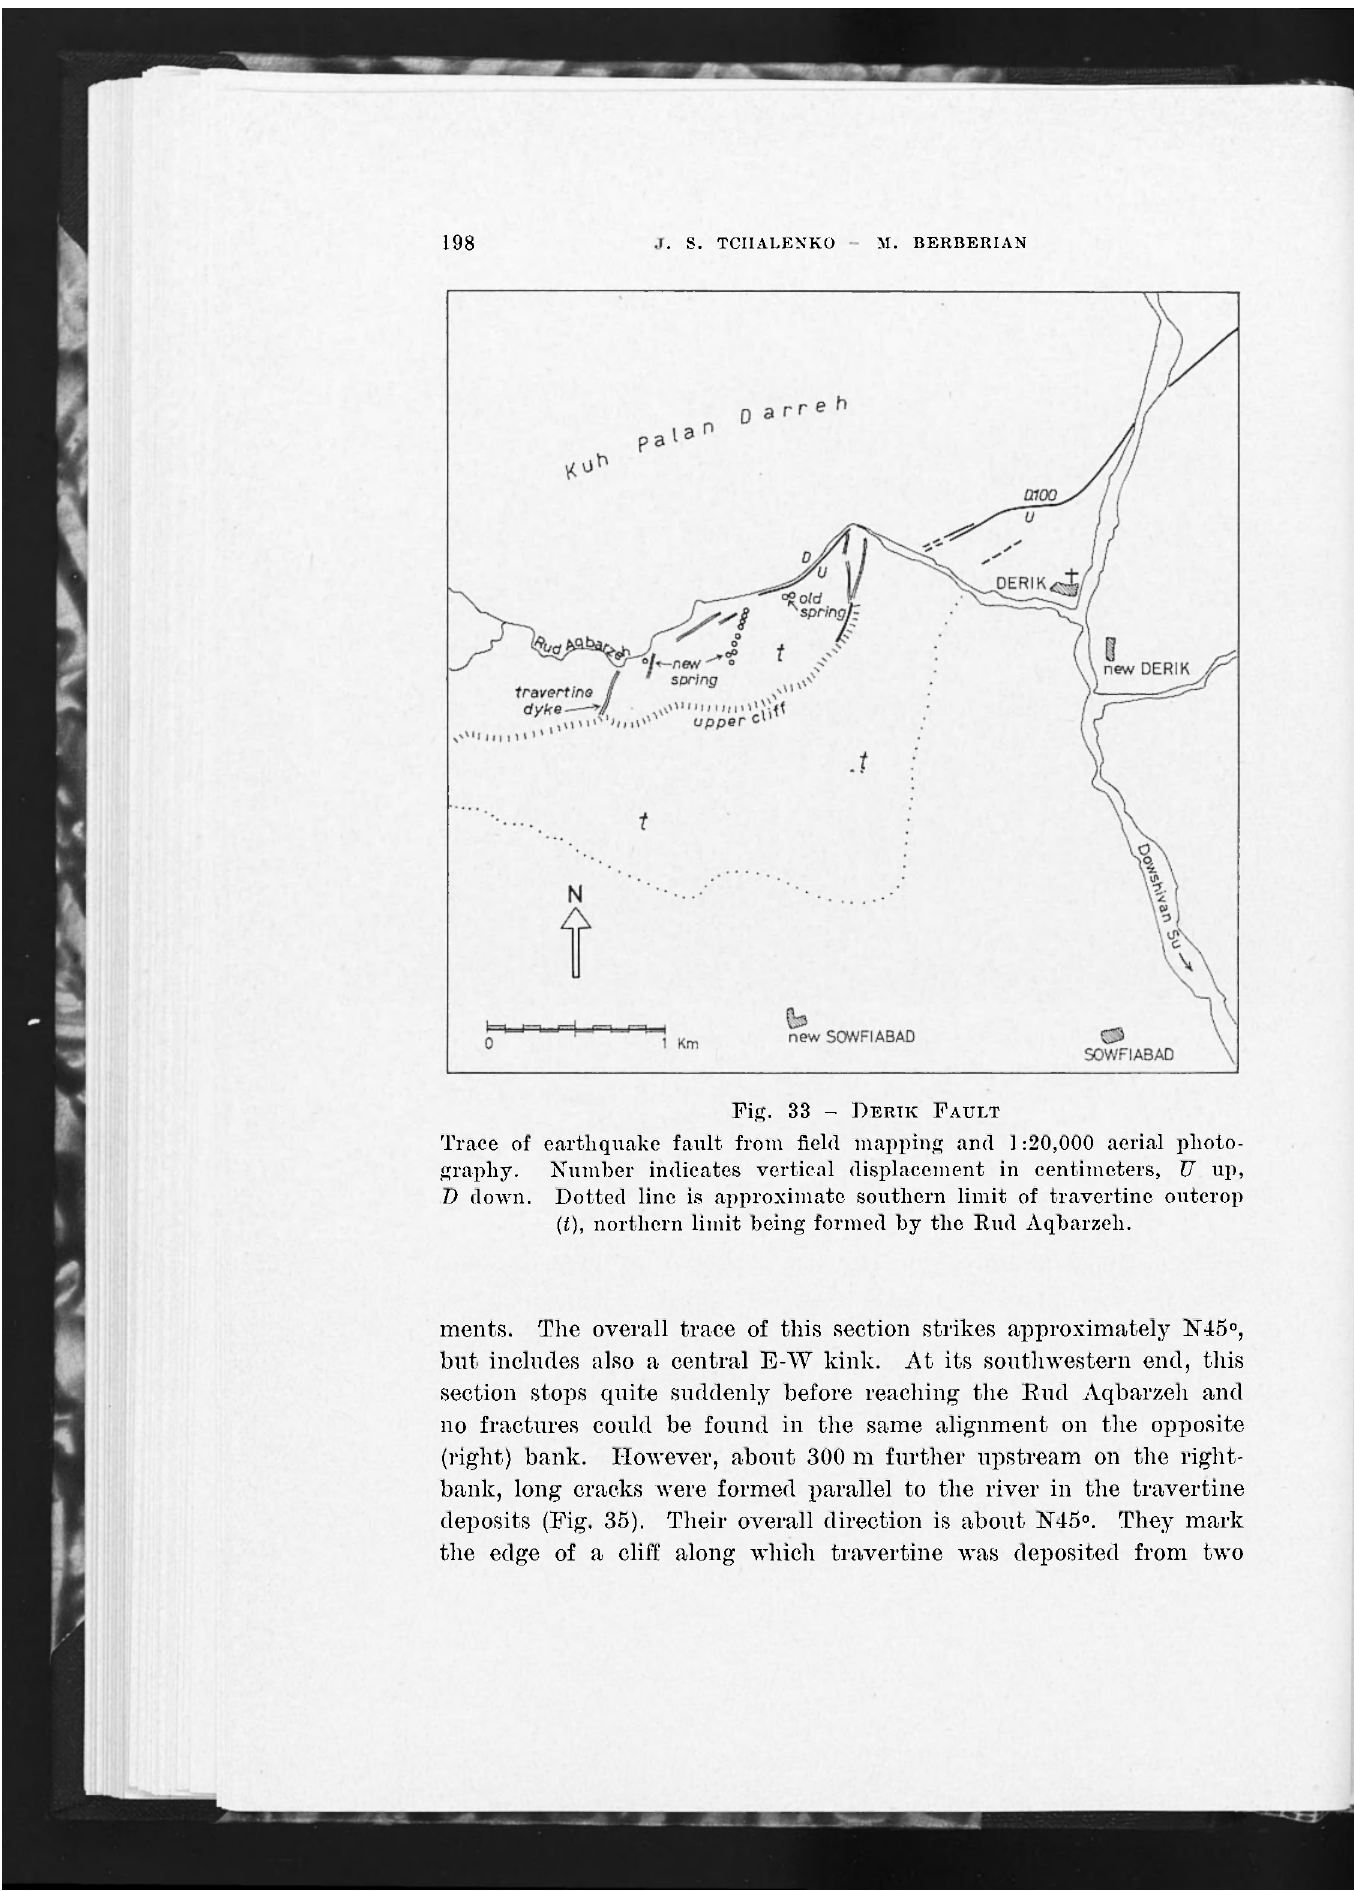
•T. S. TCIIALENKO - M. BERBERIAN